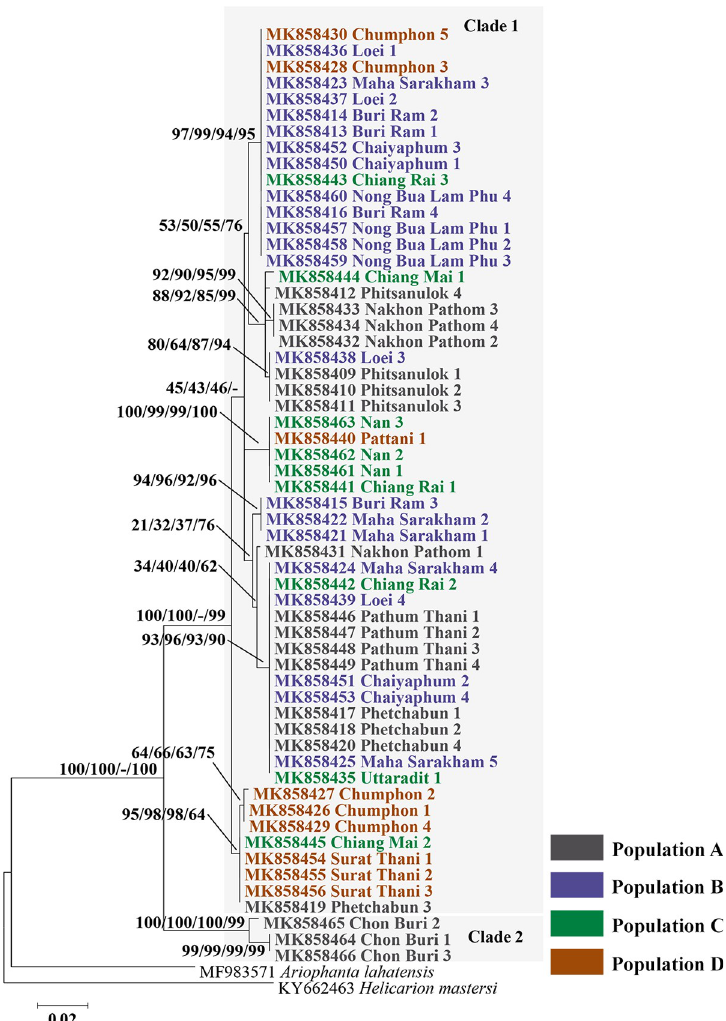
Fig 3. Maximum likelihood phylogenetic tree generated from 58 sequences of a partial COI sequence (602 bp) of C . siamensis , collected from across Thailand. Support values (ML bootstrap/NJ bootstrap/MP bootstrap/Bayesian posterior probabilities) are shown above the branches. Bold letters indicate the sequences obtained in the present study. Ariophanta lahatensis and Helicarion mastersi were used as the